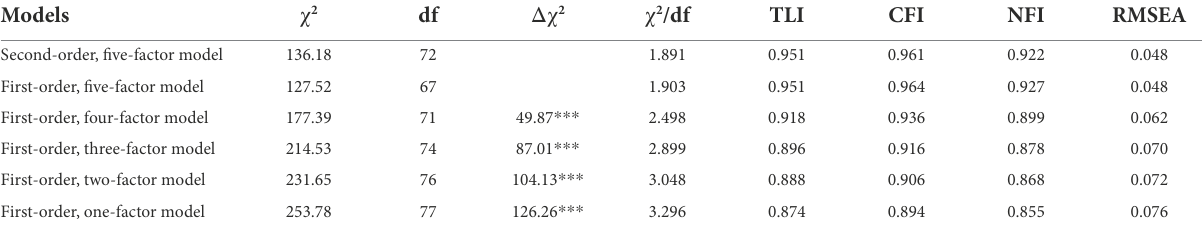
TABLE 3 Confirmatory factor analysis for TMTBSL.